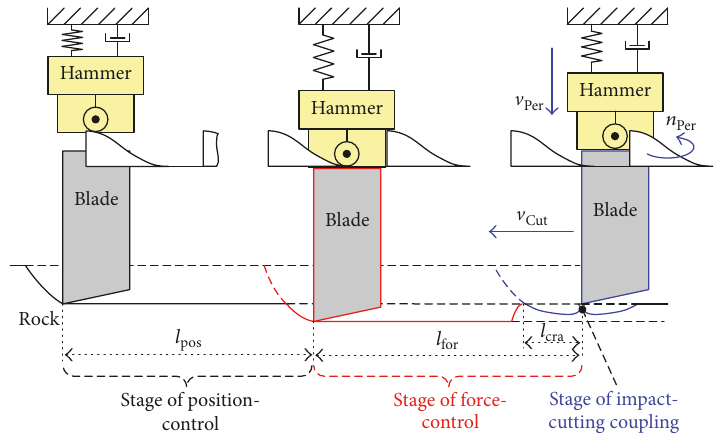
Figure 4: Fracture process for lunar rock simulant with impact-cutting coupling.